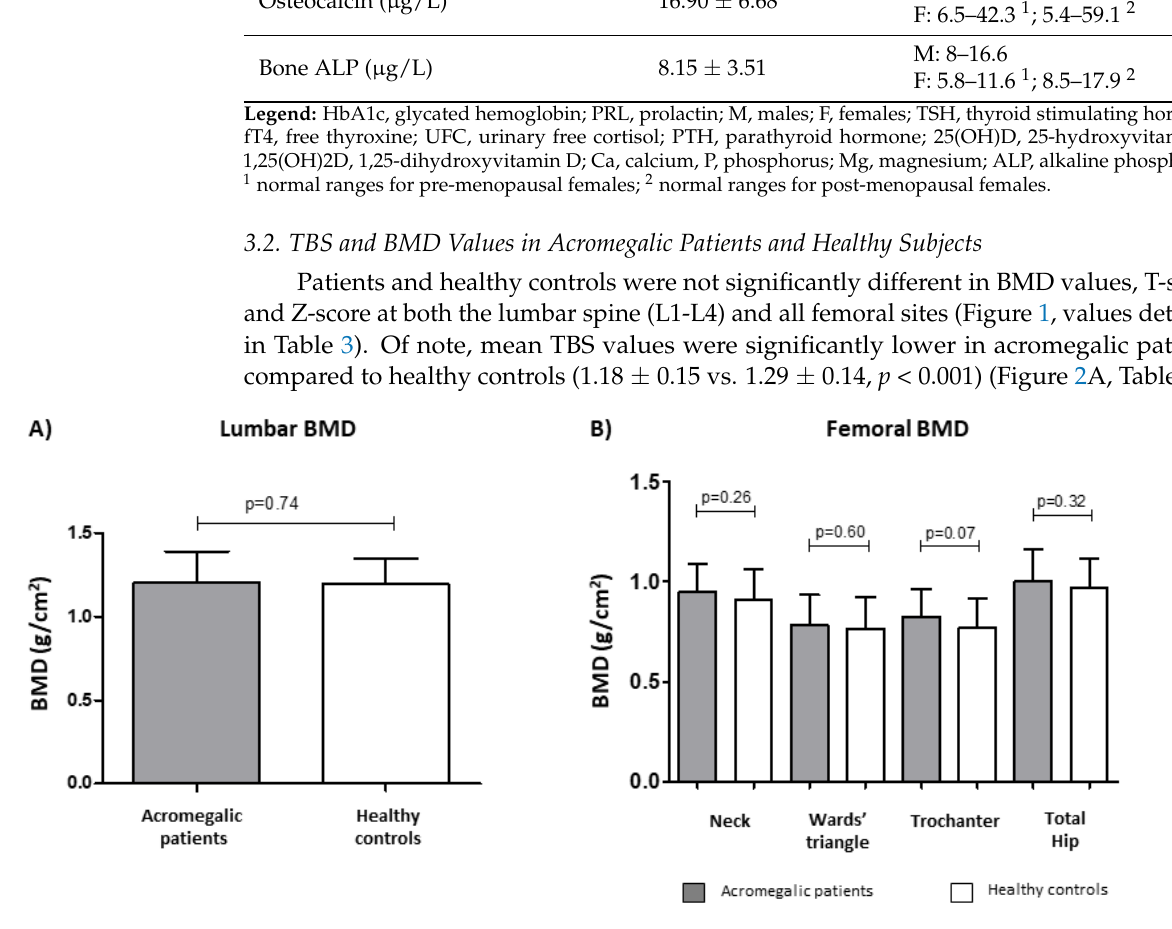
Figure 1. Mean lumbar ( A ) and femoral ( B ) bone mass density (BMD) values did not significantly differ in acromegalic patients ( n = 44) compared to age- and sex-matched healthy controls ( n = 44).